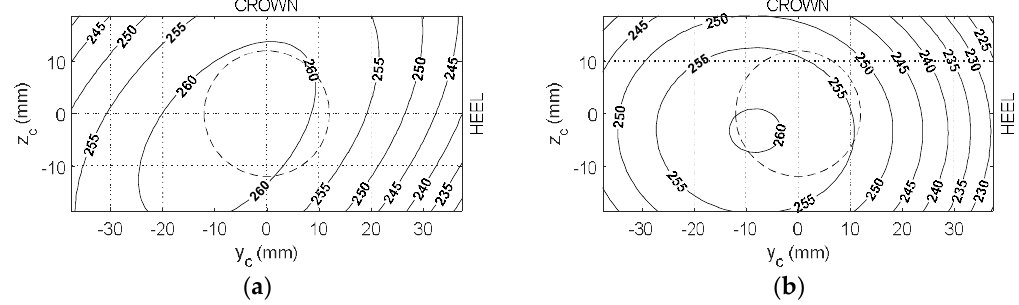
Figure 4. ( a ) Full-club ball speed (km/h); ( b ) Free-body ball speed (km/h)